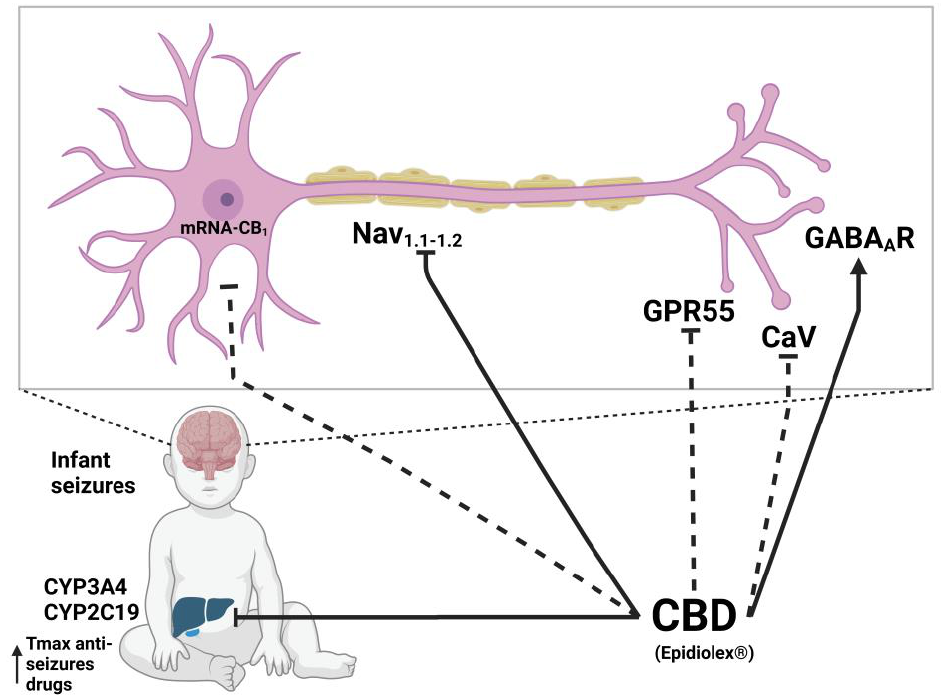
Figure 4. Molecular mechanism of CBD on epilepsy. Dotted lines refer to mechanisms recently suggested as probable based on in vitro experiments, which require verification on in vivo models. Created with Biorender.com.